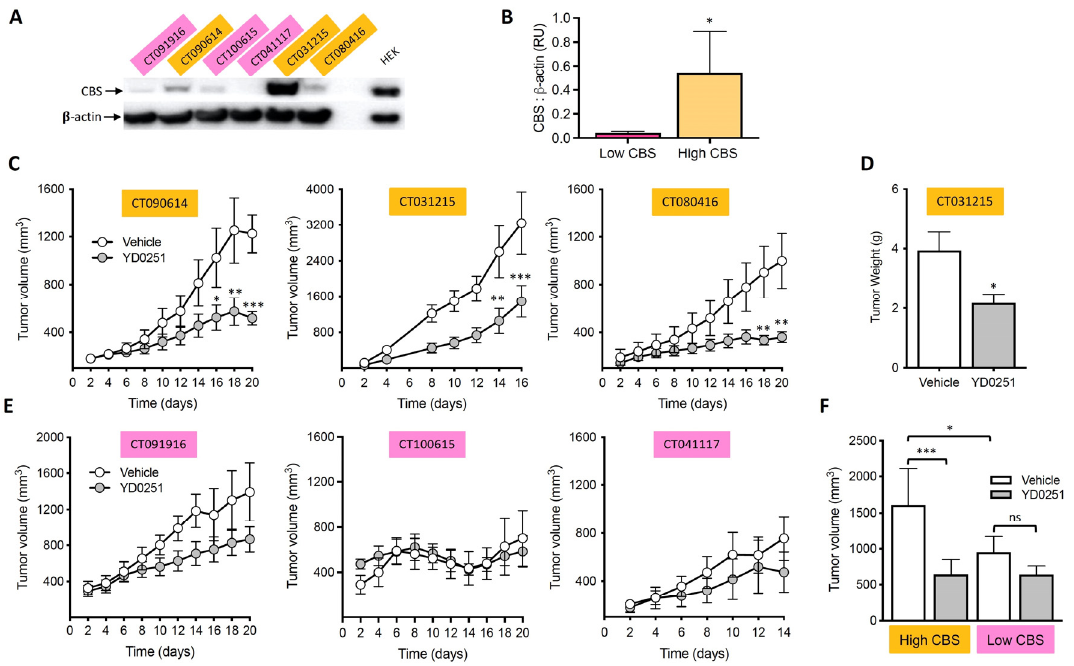
Figure 7. In Vivo efficacy of YD0251 on the growth of PDTX in nude mice. ( A ) Example Western blot showing varying levels of CBS protein in PDTXs from 6 different patients. ( B ) Comparison of the relative levels of CBS protein expression in the various tumors. ( C – E ) The effect of YD0251 (subcutaneous dosing, 6 mg/kg/day) is shown in nude mice bearing human patient-derived xenografts exhibiting high ( C , D ) or low ( E ) CBS expression. Note that YD0251 was efficacious in 6/8 patients; it was efficacious in the PDTX's of all high CBS expressors and in 50% of PDTX's of low CBS expressors (n = mice/group, * p < 0.05, ** p < 0.01, *** p < 0.001, ns: not significant). It was found that 1 PDTX with high CBS levels and 2 PDTXs with low levels of CBS possessed activating mutations of the KRAS gene. The KRAS status of the tumors did not correlate with the growth inhibitory efficacy of YD0251. Overall, high CBS-expressing PDTXs grew faster and the effect of YD0251 was more pronounced in them than in low CBS-expressing PDTXs ( F ).